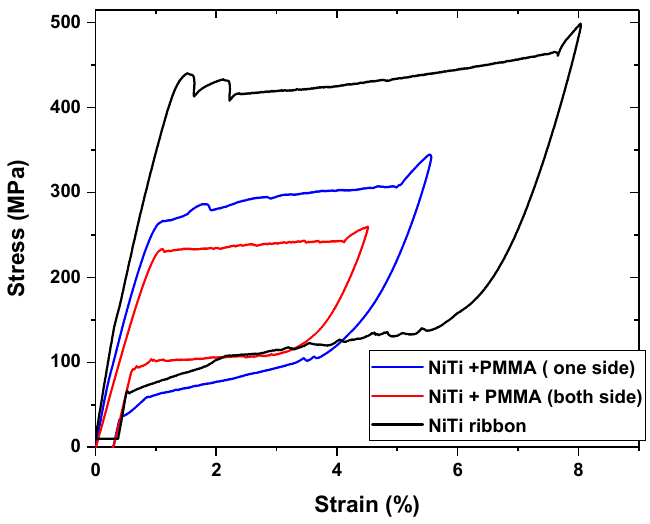
Figure 11. Stress–strain curves for the Ni-Ti ribbon and its corresponding hybrid composite.